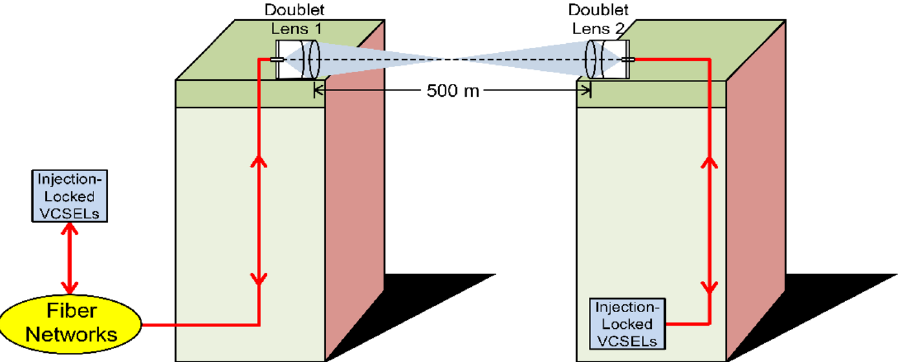
Figure 4. The layout of the doublet lenses-based two-way fibre-FSO converged